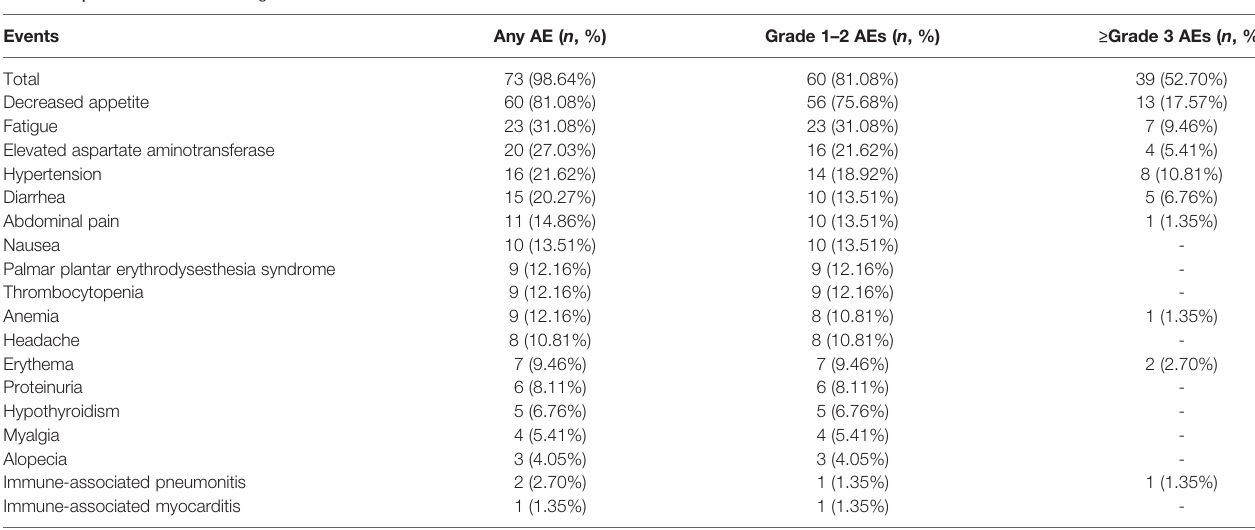
TABLE 4 | Adverse events